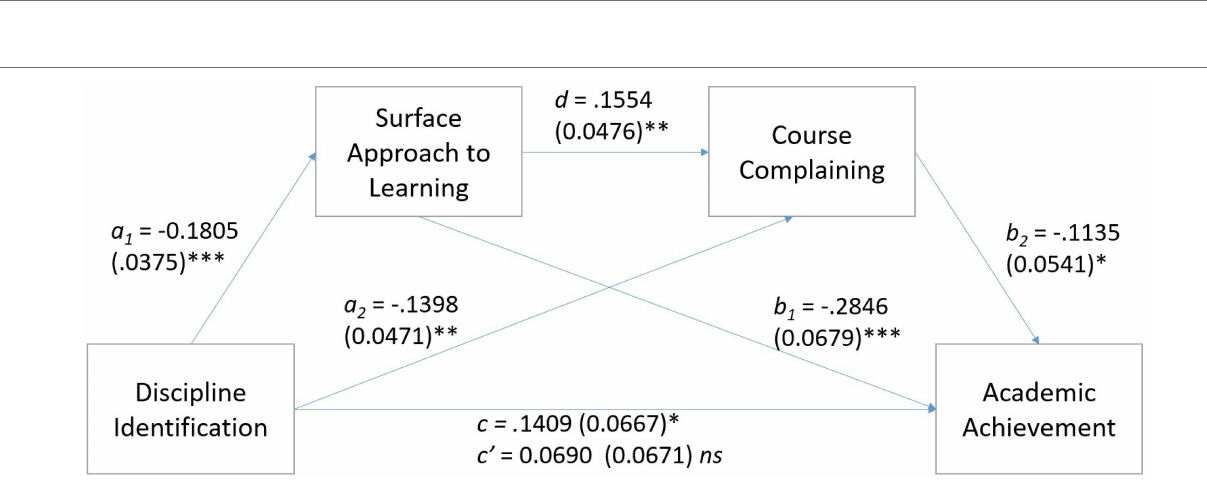
FIGURE 1 | Serial mediation of deep approach to learning and course complaining on the relation between discipline identification and academic achievement (standard errors are shown in parentheses). * p < 0.05, ** p < 0.01, and *** p < 0.001.